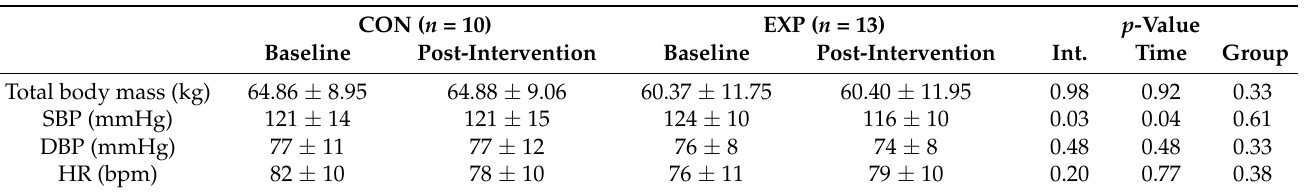
Table 1. Participants’ characteristics and hemodynamic variables at rest in experimental and control groups at baseline and post-intervention.